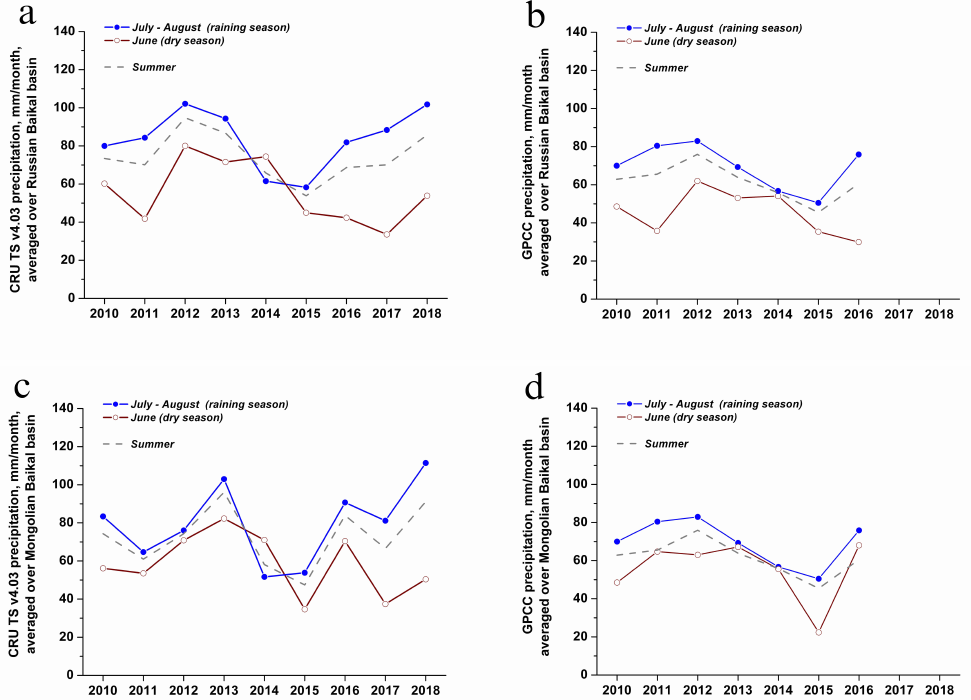
Figure 9. The monthly total precipitation (mm / month), spatially averaged over the territory of the Russian ( a , b ) and the Mongolian parts ( c , d ) of the Baikal basin, and temporally averaged over the wet period (July–August, blue lines), the dry period (June, brown lines), and the whole summer (June–August, gray dashed lines). The CRU TS precipitation datasets (2010–2018) are presented in panels ( a , c ); the GPCC precipitation datasets (2010–2016) are presented in panels ( b , d